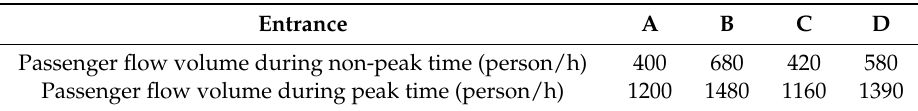
Table 5. Passenger flow volume at each